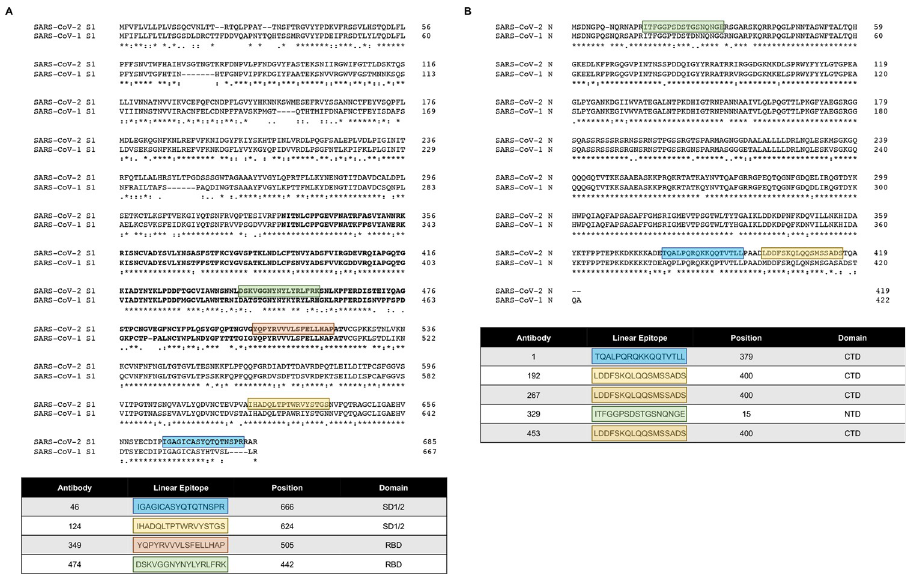
Fig 3. SARS-CoV-2 S1 and N protein alignment and linear epitope mapping of the mAbs. (A) Clustal Omega- generated amino acid sequence alignment of SARS-CoV-2 S1 and SARS-CoV-1 S1. The epitope recognized by each mAb is indicated by the highlighted boxes, the position of the epitope is noted. SD1/2, subdomain 1/2. RBD, receptor binding domain. The amino acids representing the RBD are in bold. (B) Clustal Omega-generated amino acid sequence alignment of SARS-CoV-2 N and SARS-CoV-1 N. The epitope recognized by each mAb is indicated by the highlighted boxes, the position of the epitope is noted. CTD, C terminal domain. NTD, N terminal domain. � , single, fully conserved residue;:, conservation between groups of strongly similar properties (i.g., those scoring > 0.5 in the Gonnet PAM 250 matrix); •, conservation between groups of weakly similar properties (i.e., those scoring � 0.5 in the Gonnet PAM 250